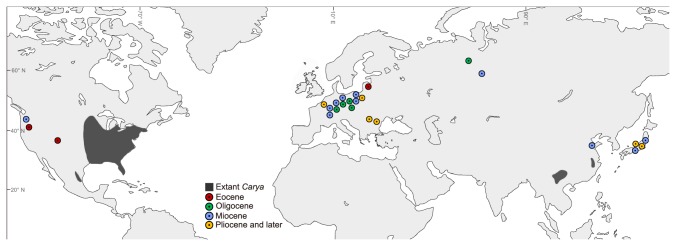
Geographic distribution of both extant and extinct Carya species.The black areas indicate the geographical distribution of extant Carya showing its disjunction between EA and ENA. Colored circles denote the locations of Carya fruit fossils (detailed information of each fossil in Table S4).